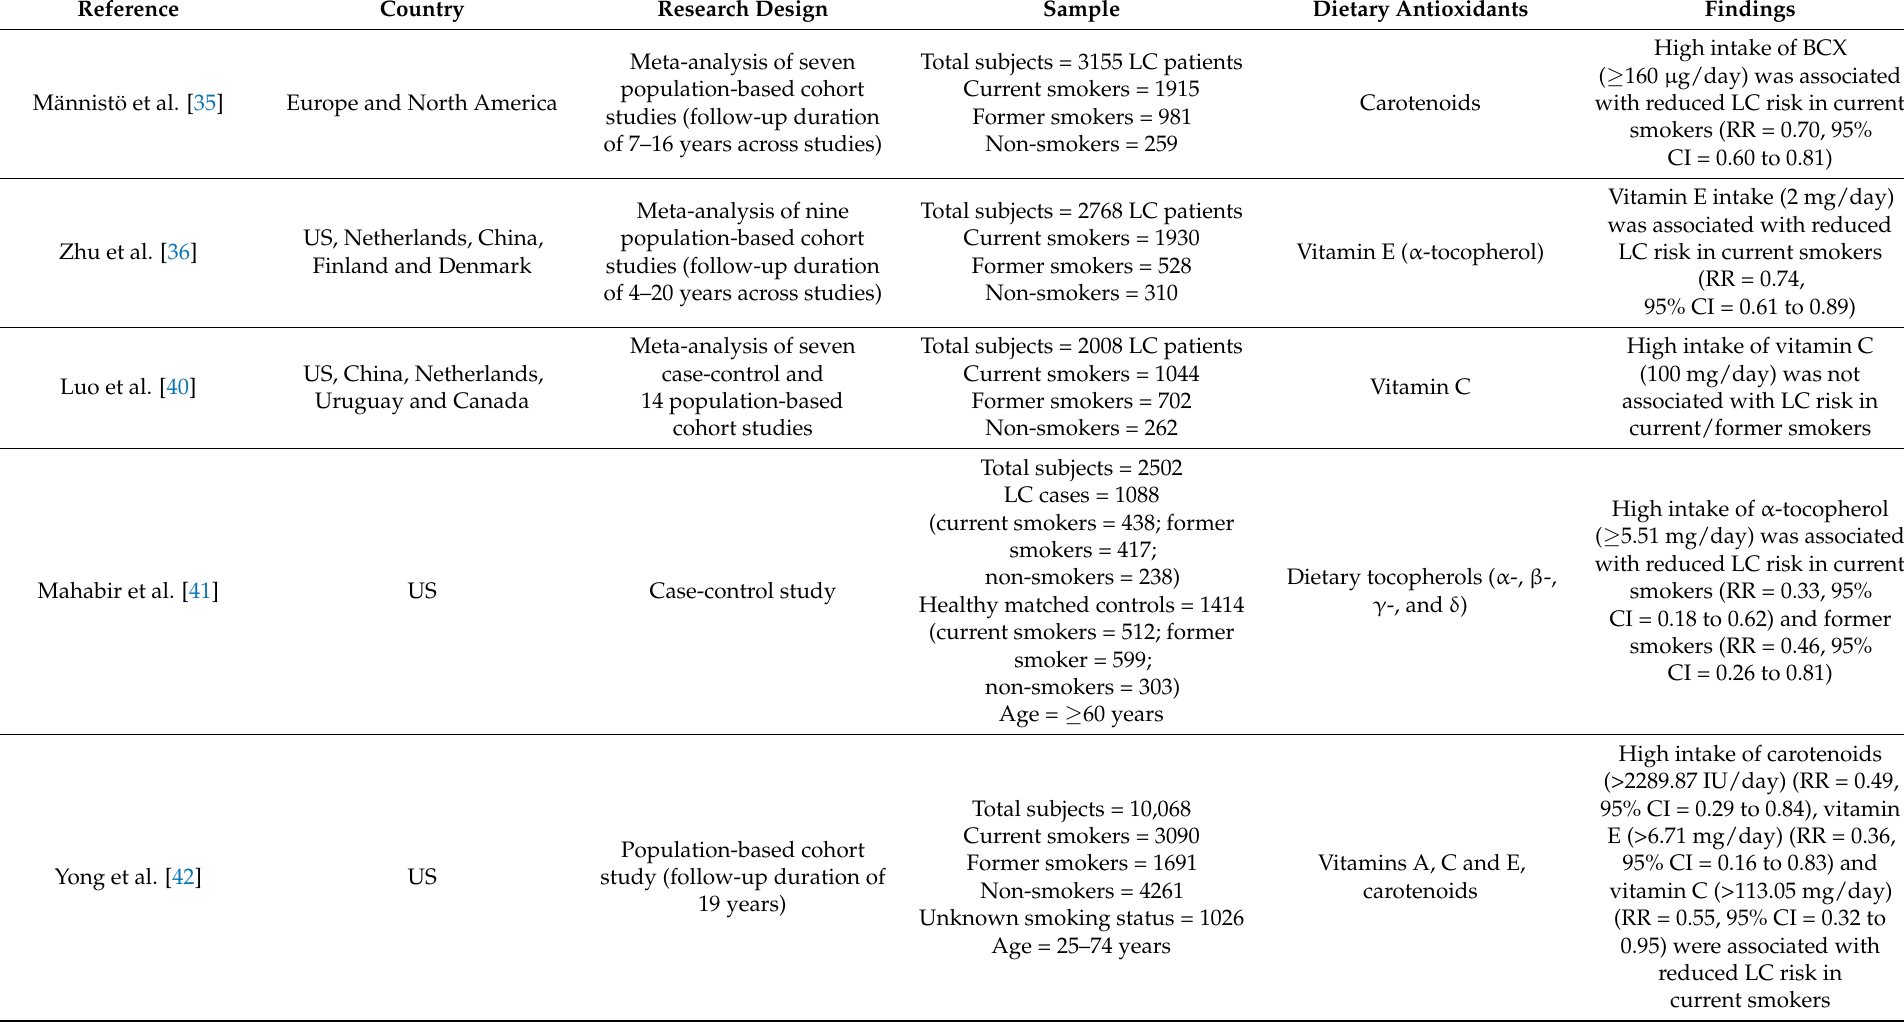
Table 1. Dietary antioxidants and the risk of LC in smokers and